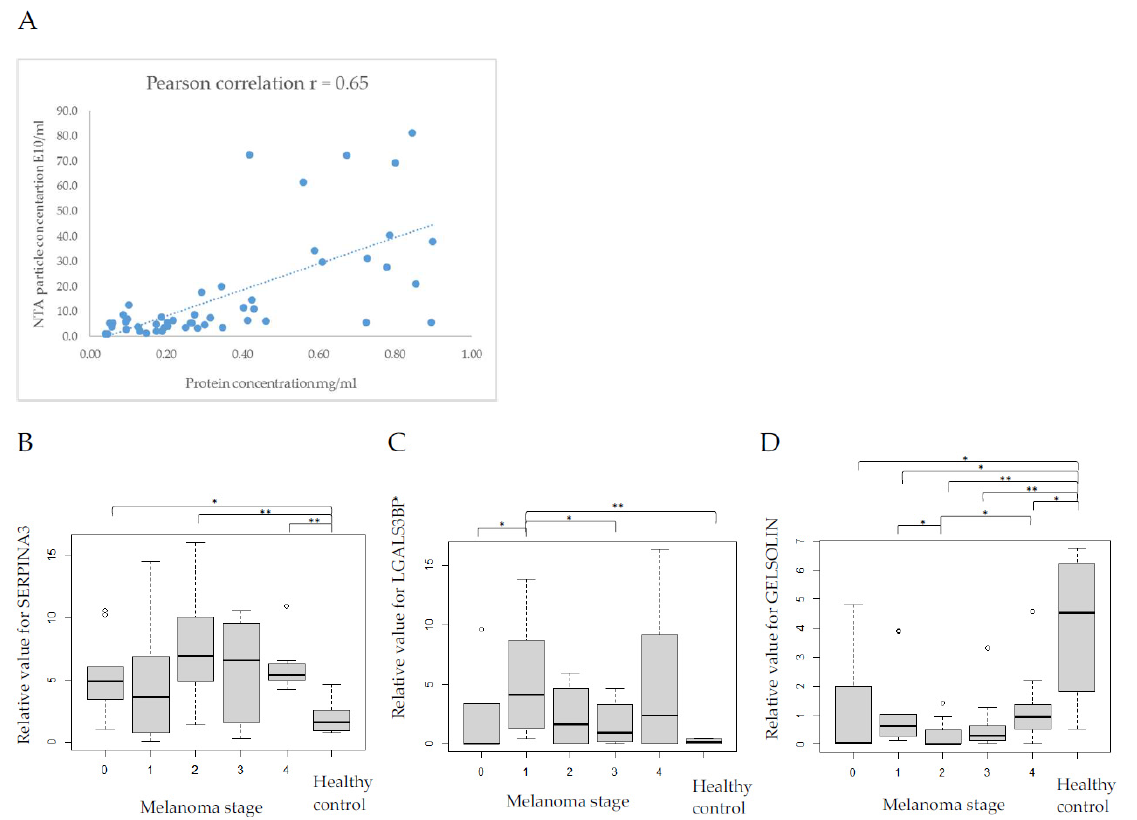
Figure 3. Analysis of EVs purified from patients with melanoma using ultracentrifugation. ( A ) Correlation analysis of the concentration of EVs measured by NTA and the total protein concentration measured by Bradford protein assay. ( B ) The relative values of the SERPINA3 signal obtained from the immunoblot analysis of EVs grouped by melanoma stages. ( C ) The relative values of the LGALS3BP signal obtained from the immunoblot analysis of EVs grouped by melanoma stages. ( D ) The relative values of gelsolin signal obtained from the immunoblot analysis of EVs grouped by melanoma stages. N—number of patients analyzed. The results indicated with * had a statistically significant difference compared to value of PBS-treated sample: * p -value < 0.05; ** p -value < 0.01.